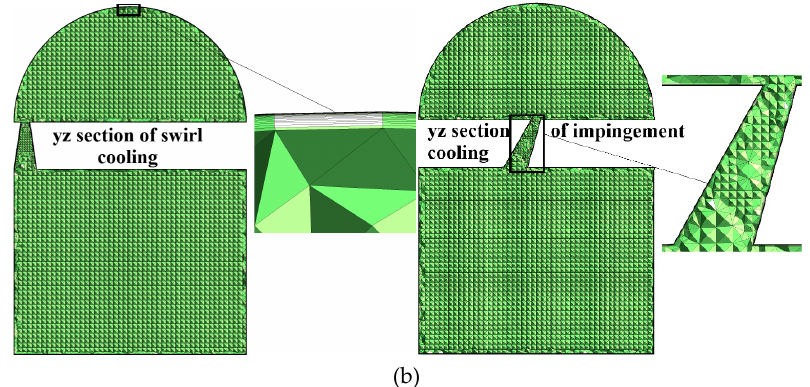
Figure 7. Unstructured fine mesh details of the compound cooling unit. ( a ) 3D view; ( b ) yz sections of swirl and impingement nozzles.